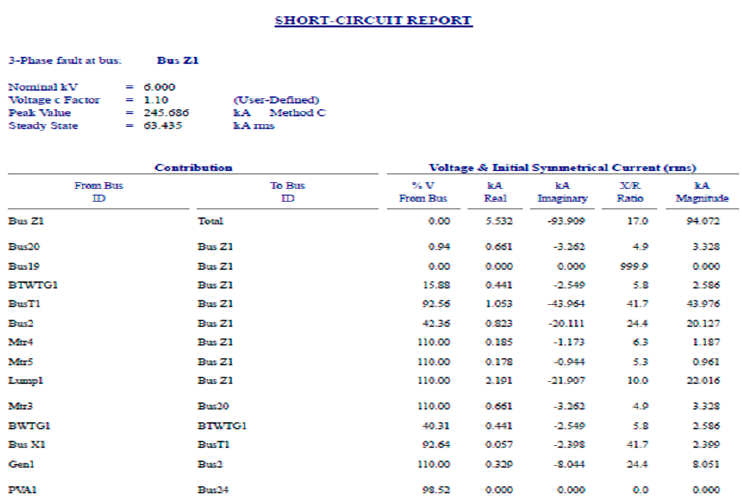
Figure 9. Short-circuit report: three-phase fault at bus Z1.